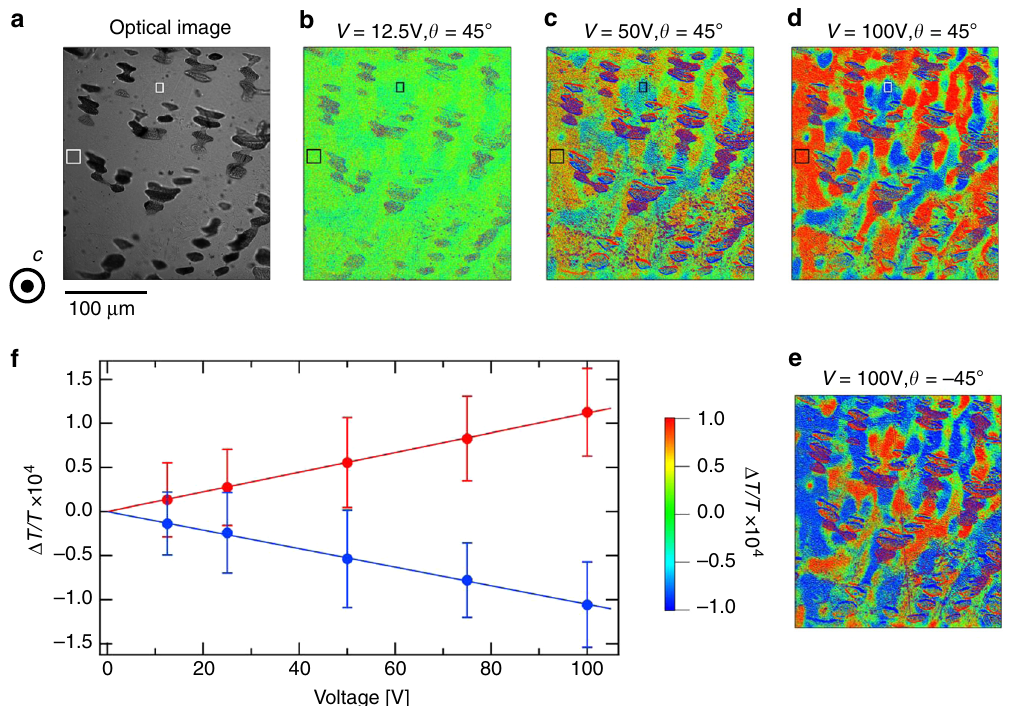
Fig. 5 Applied voltage dependence of the intensity map of electrogyration in NiTiO 3 . a Transmission optical microscopy image with the incidence of unpolarized light along the c axis (Scale bar: 100 μ m). Dark areas in the image correspond to NiO impurity. b – e The two-dimensional maps of electrogyration at the same area as ( a ). To obtain the maps, the difference of the transmission microscope images at the positive and the negative voltages divided by the average of them ( Δ T / T ) was calculated for each pixel detection. A 3 × 3 median fi lter was applied to the raw images. The polarization con fi guration was set at ( b – d ) θ = + 45° and ( e ) − 45°. The applied voltage V was ( b ) ±12.5 V, ( c ) ±50 V, and ( d , e ) ±100 V. A Δ T/T color scale is applied to the images in ( b – e ). f The V dependence of the average of Δ T / T taken at θ = + 45° in the selected single domain areas denoted by boxes ( a – d ). The red and blue dots correspond to the data of the areas surrounded by large and small boxes, respectively, in each panel. The standard deviation is shown as an error bar. The lines denote least squares fi tting